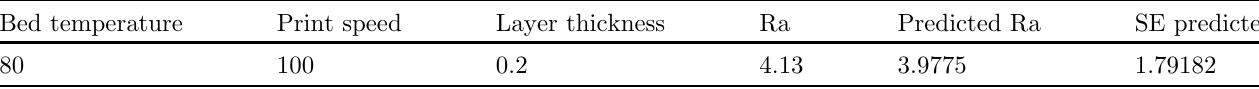
Table 5. Validation result for bottom surface roughness.